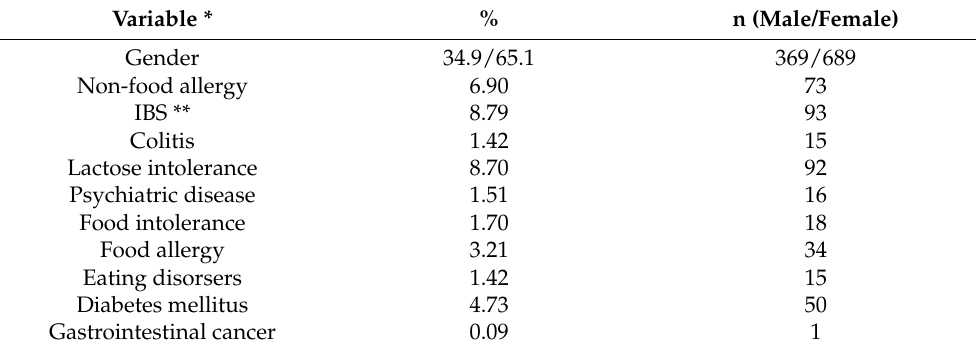
Table 1. Demographic and clinical characteristics of the studied